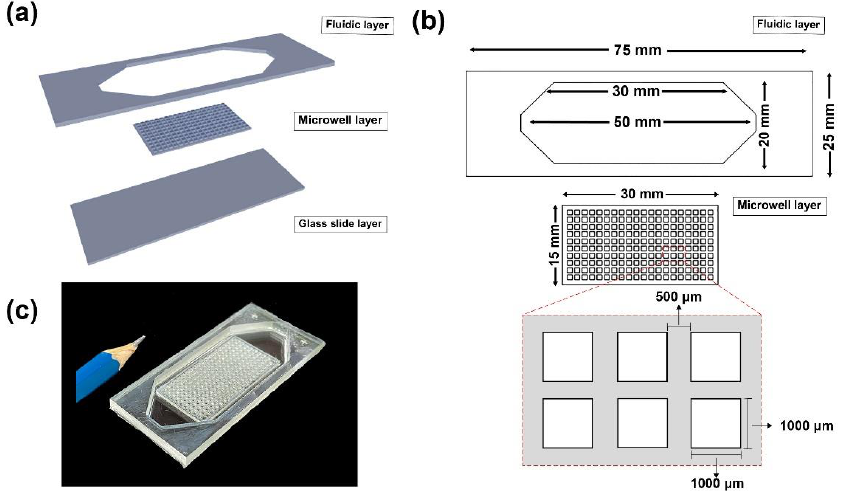
Figure 1. The microwell-based microfluidic (MBM) device for single-cell isolation. ( a ) The component of the MBM device includes a fluidic layer, a microwell layer, and a glass slide layer. ( b ) The details of the MBM device. ( c ) Image of the fabricated MBM device.